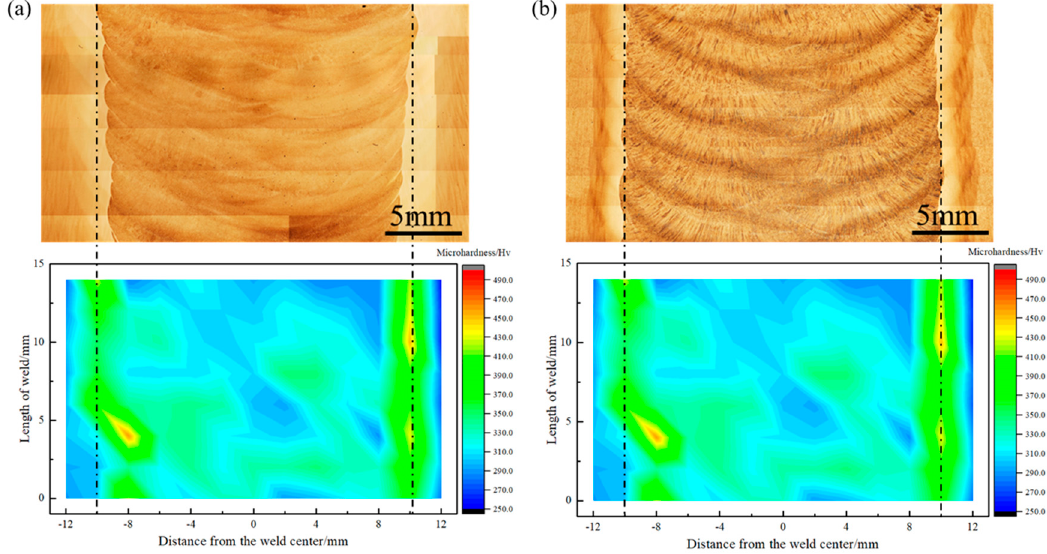
Figure 8. Micro-hardness maps of weld metal: ( a ) TIG, ( b ) SAW .